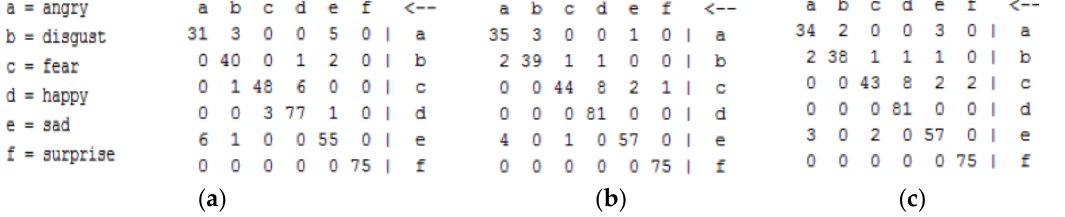
Figure 8. Confusion Matrix. ( a ) Linear SVM; ( b ) Polynomial kernel SVM; ( c ) Radial basis function Kernel SVM.